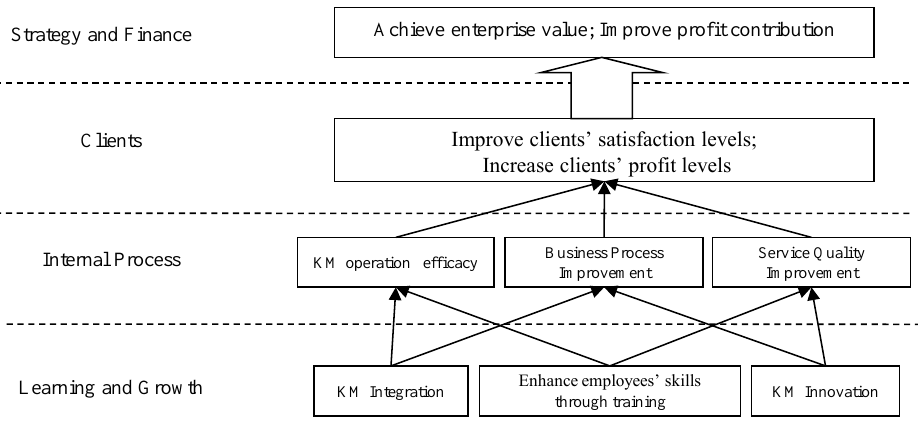
Figure 2. The causal relationship between KM and BSC.